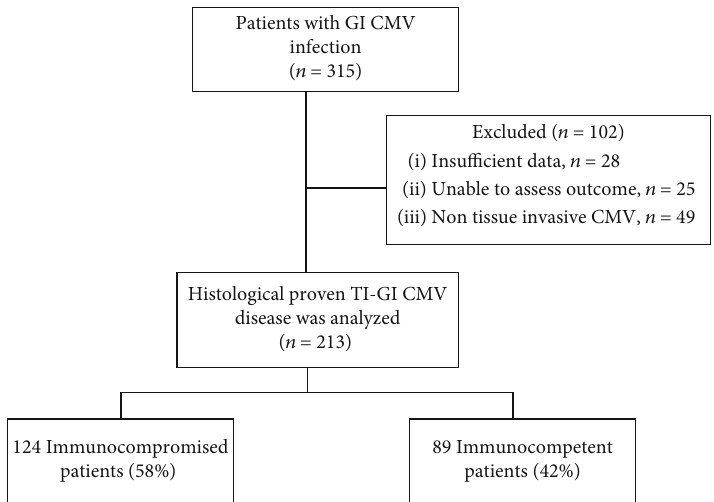
Figure 1: Study fl ow chart. Abbreviations: CMV: cytomegalovirus; GI: gastrointestinal; TI: tissue